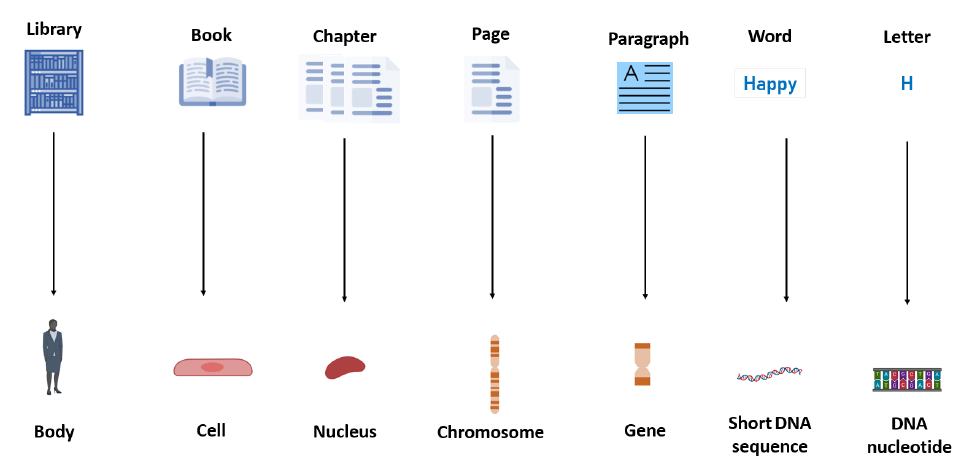
Figure 1. Comparison of printed and genetic information. Table 1. Difference between locus, gene, and